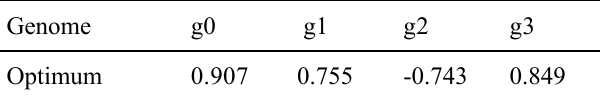
Table 5. Parameters of the proposed model